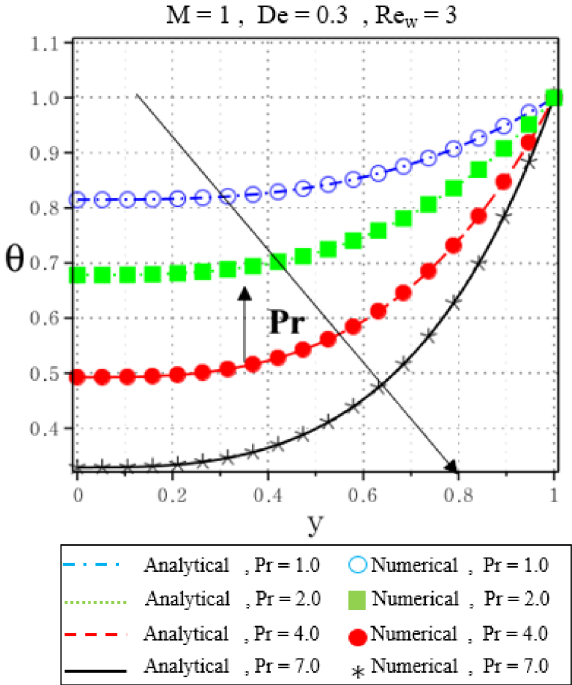
Figure 10. Dimensionless temperature predicted by analytical and numerical method (NUM) for different Pr Prandtl number at M = 1, Re w = 3, De = 0.3, (cid:125) = −